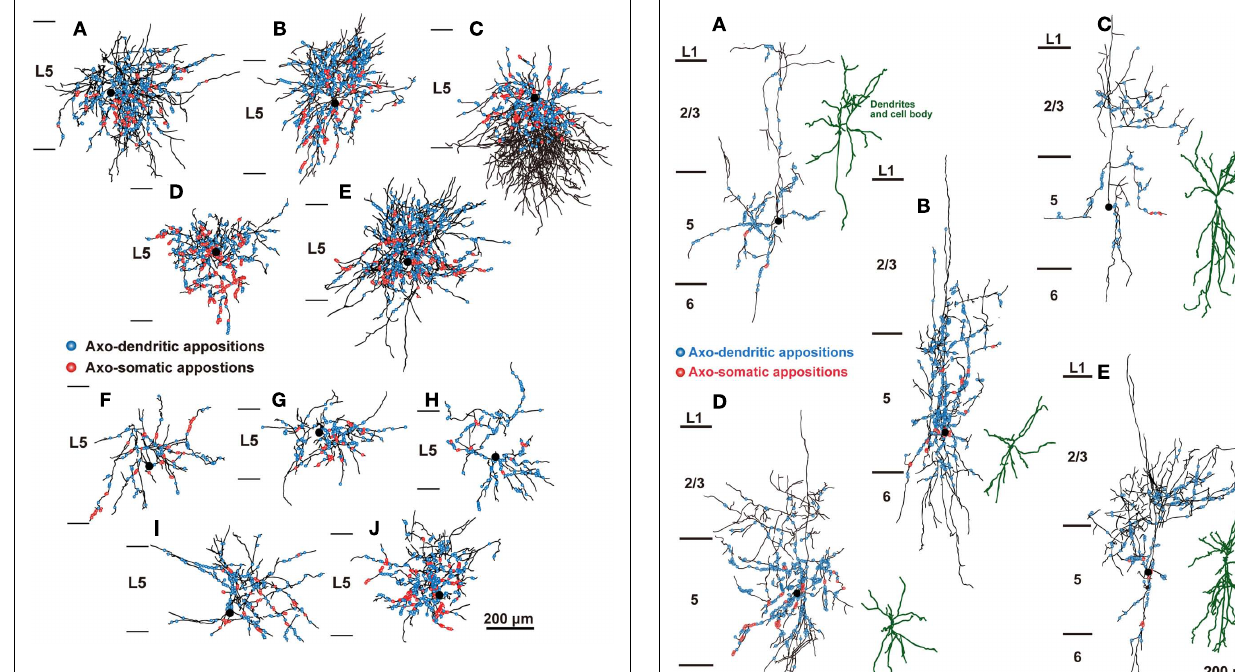
FIGURE 4 |The distribution of axon boutons of FS neurons in close appositions to CSNs. Axons of L5 FS1 (A–E) and FS2 neurons (F–J) were reconstructed with camera lucida and projected to the frontal plane. Black lines and filled circles are axons and cell bodies of FS neurons, respectively. Blue and red circles indicate the axodendritic and axosomatic appositions, respectively. Scale bar in (J) applies to (A–J) .